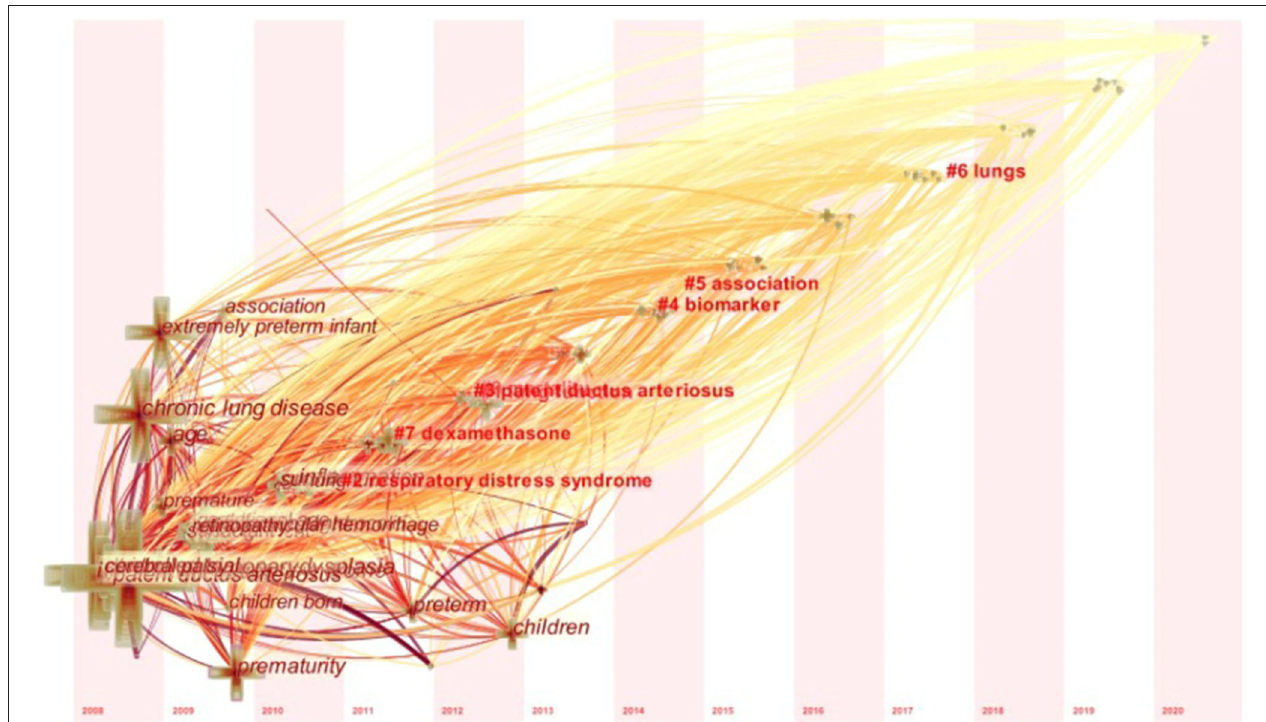
FIGURE 5 | Timeline-zone of Keywords on BPD in extremely pre-mature